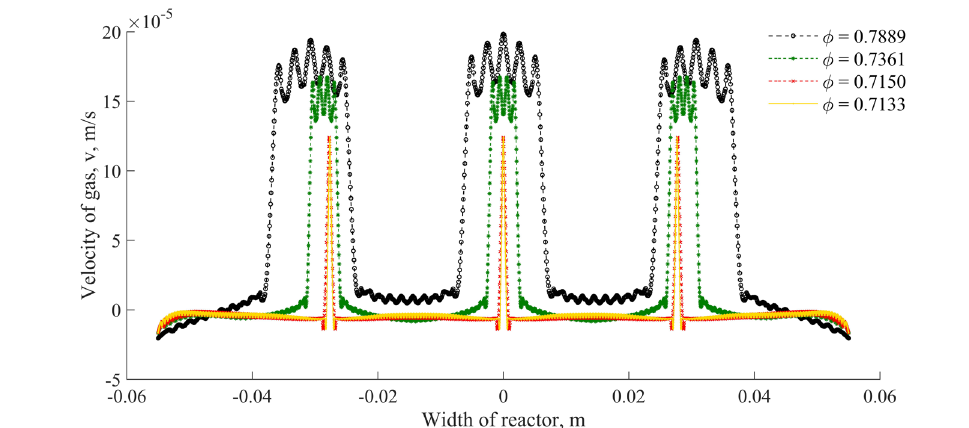
Fig. 6. The effect of voidage of the fixed bed (φ) on the velocity profile of gas at constant pressure gradient, lattice speed (cs) and dynamic viscosity